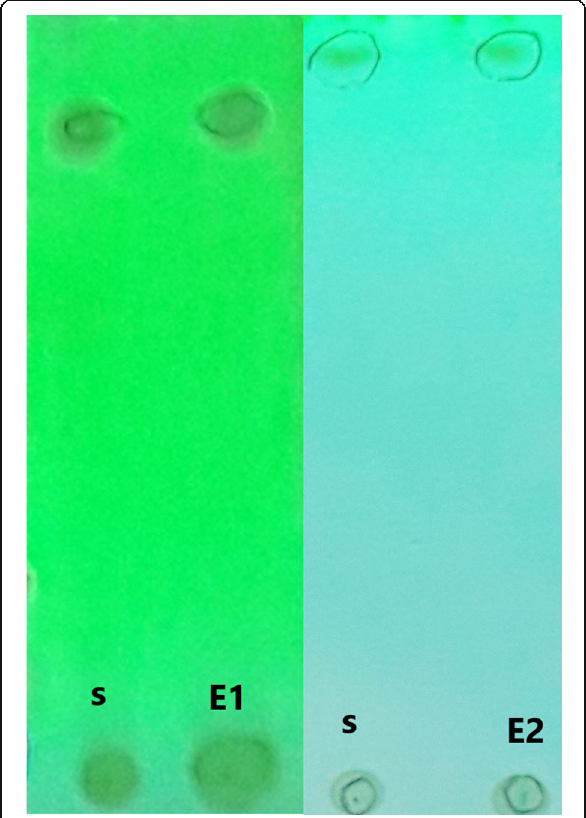
Fig. 3 Thin layer chromatography of standard and aqueous and ethanolic extracts